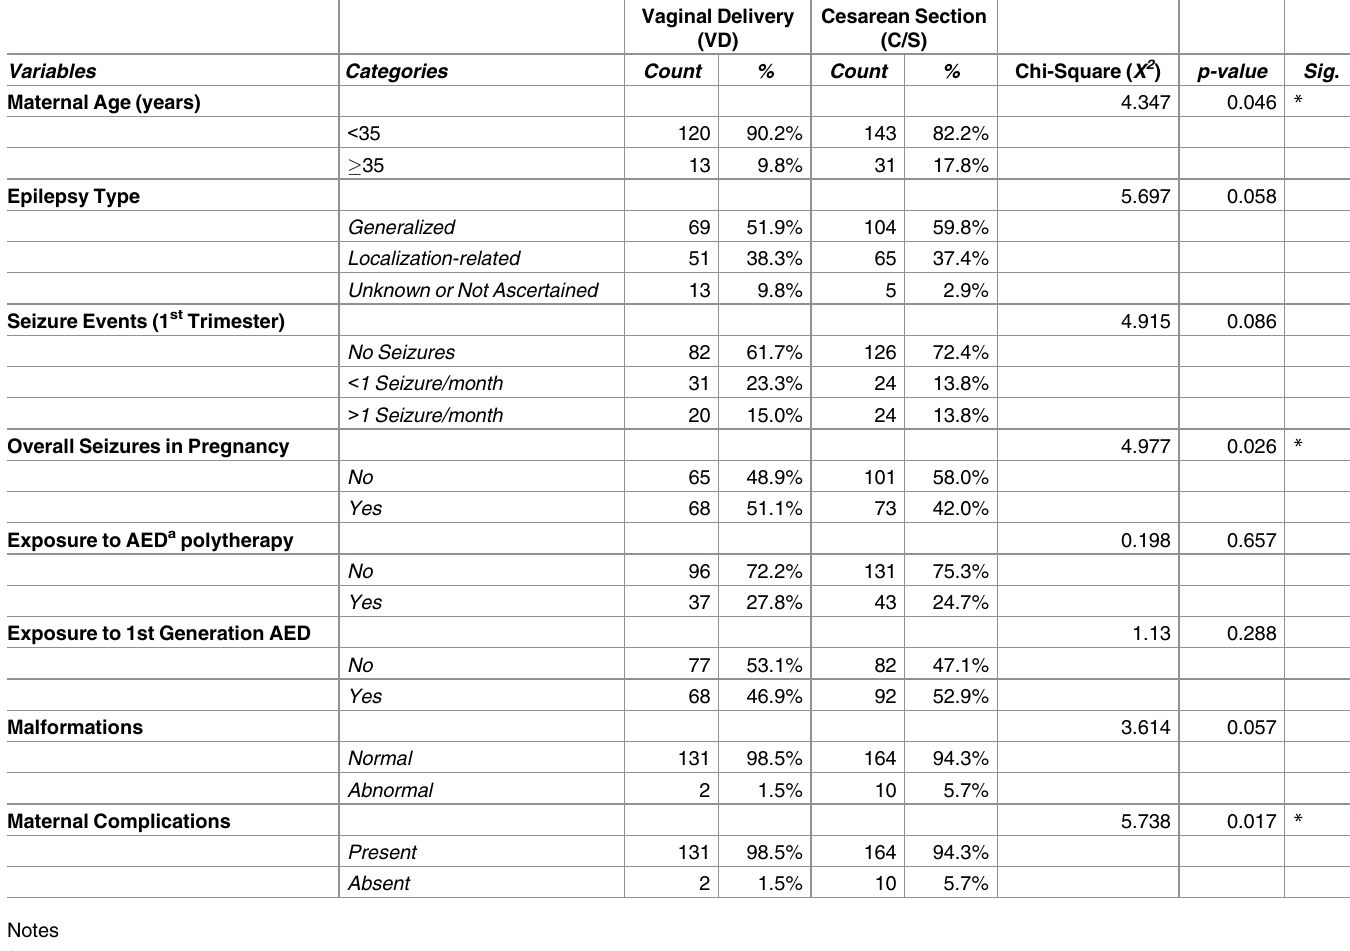
Table 2. WWE related factors by delivery group (N = 307; aborted: n = 11